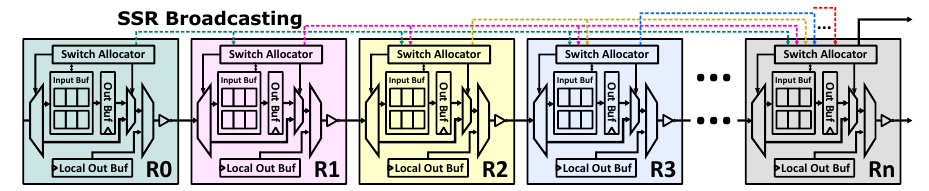
Figure 1. Architecture of SMART NoC.